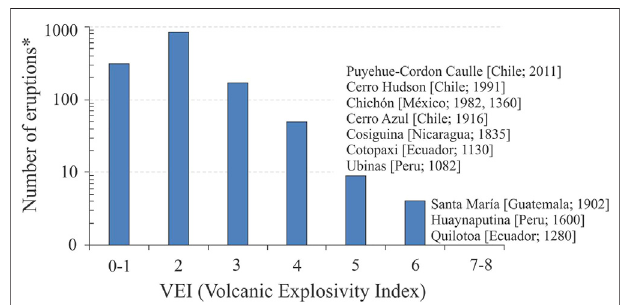
FIGURE2| NumberofvolcaniceruptionssortedbyVEIinthepast1,000 years. Data compiled from Global Volcanism Program (GVP) database (https://volcano.si.edu), *considering, for all VEIs, both con fi rmed and uncertain events. The large VEI events (VEI 5 and 6) are displayed in the diagram according to their